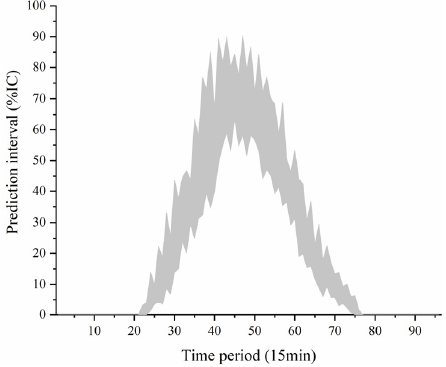
Figure A2. Prediction intervals of solar power stakeholder.